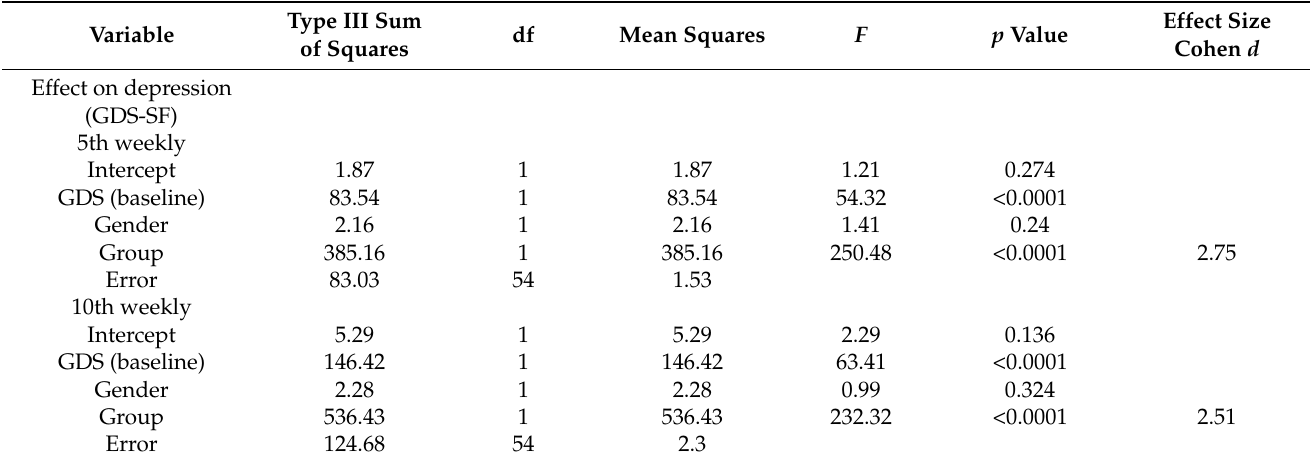
Table 4. Effect of music intervention on depression at different timepoints ( N =